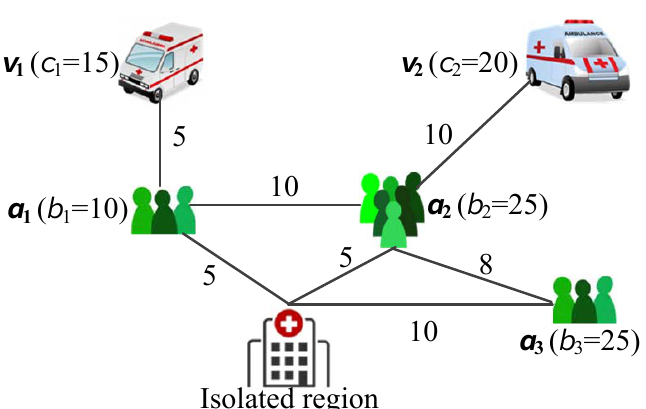
Figure 2. A simple problem instance with two vehicles and three areas. We assume that the vehicles have the same velocity, and the label on a line denotes the travel time between two areas; we also assume that the loading time interval (cid:52) t j is 0.5 for all three